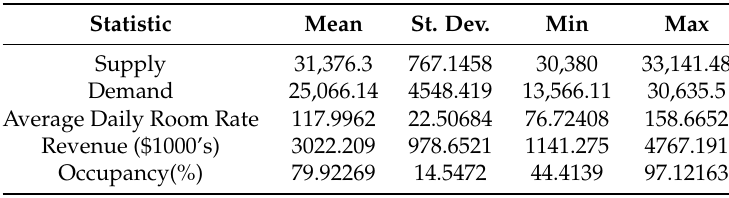
Table 3. Summary statistics, conventions.